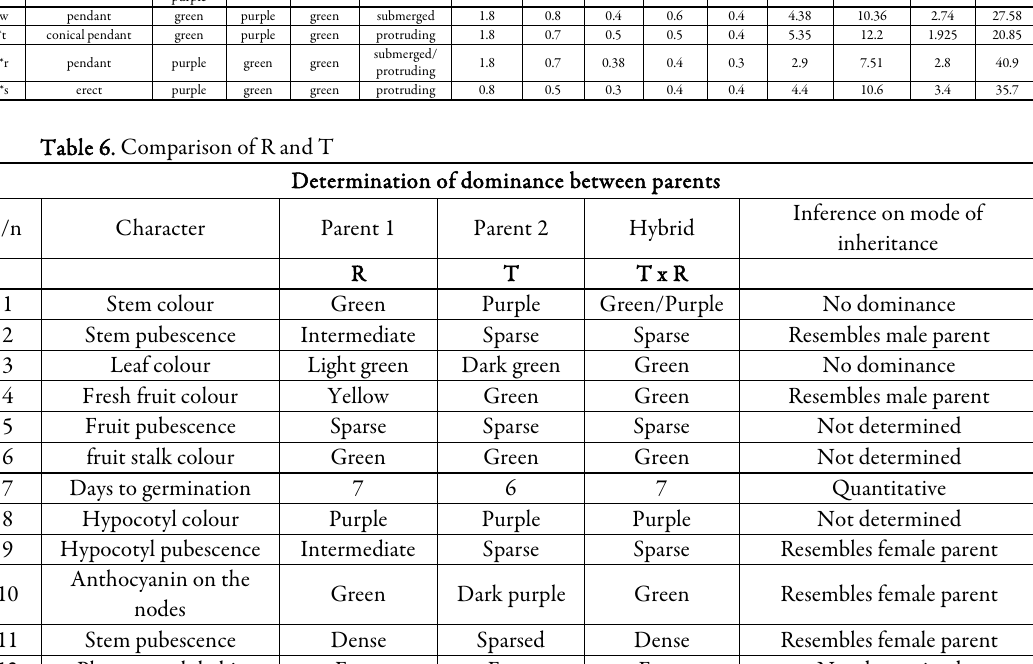
Table 6. Comparison of R and